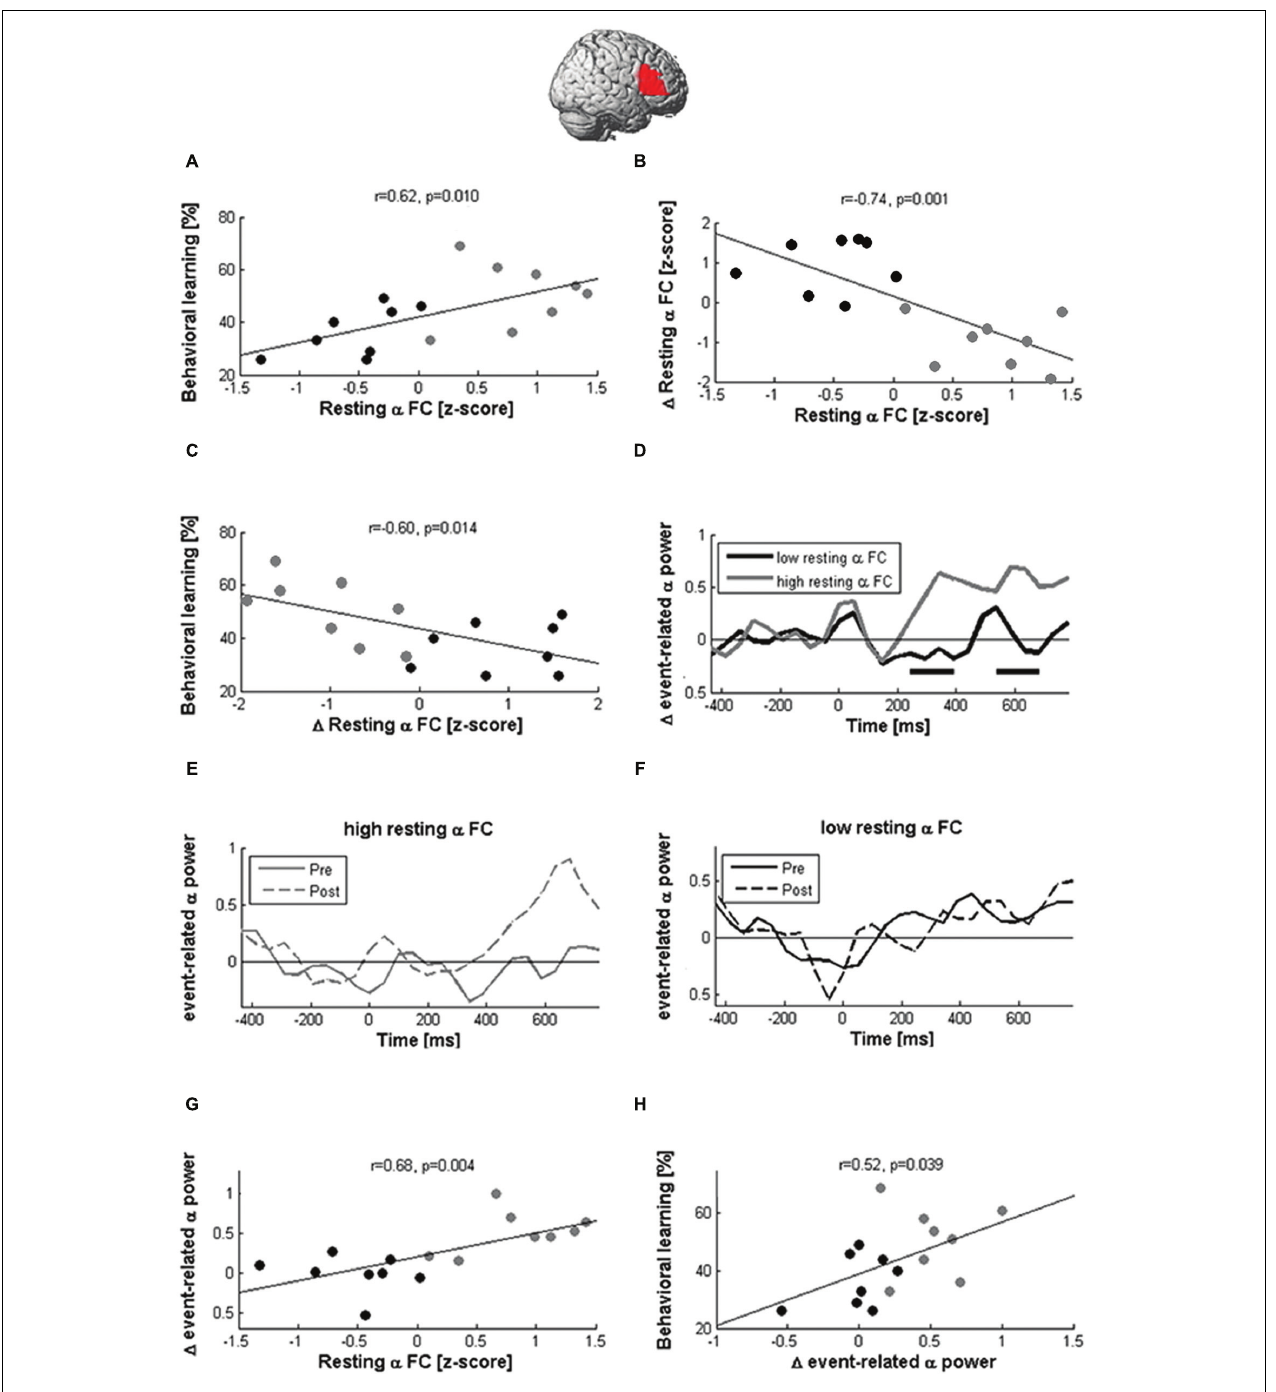
FIGURE 7 | Network states modulate the effects of cTBS. Learning and EEG after-effects of cTBS depended on the magnitude of resting-state alpha coherence between the right IFG and the rest of the brain before stimulation. Participants with large pre-stimulation coherence learned more words (A) and decreased alpha-band coherence after stimulation (B) , while participants with low pre-stimulation connectivity showed the opposite pattern. The reduction of coherence between the right Broca homolog and the rest of the brain was correlated with better learning performance (C) . In participants with high pre-stimulation coherence, cTBS also produced the expected local inhibition during naming, as indicated by an increase of event-related alpha power ( D,E ; black rectangles indicate significant differences at p < 0.05). In contrast, participants with low pre-stimulation alpha-band coherence showed no power modulation after stimulation (F) . Hence, resting-state coherence (rsCOH) before stimulation was associated with greater alpha power increases between 200 and 800 ms after picture presentation (G) , which was in turn correlated with better learning (H) .